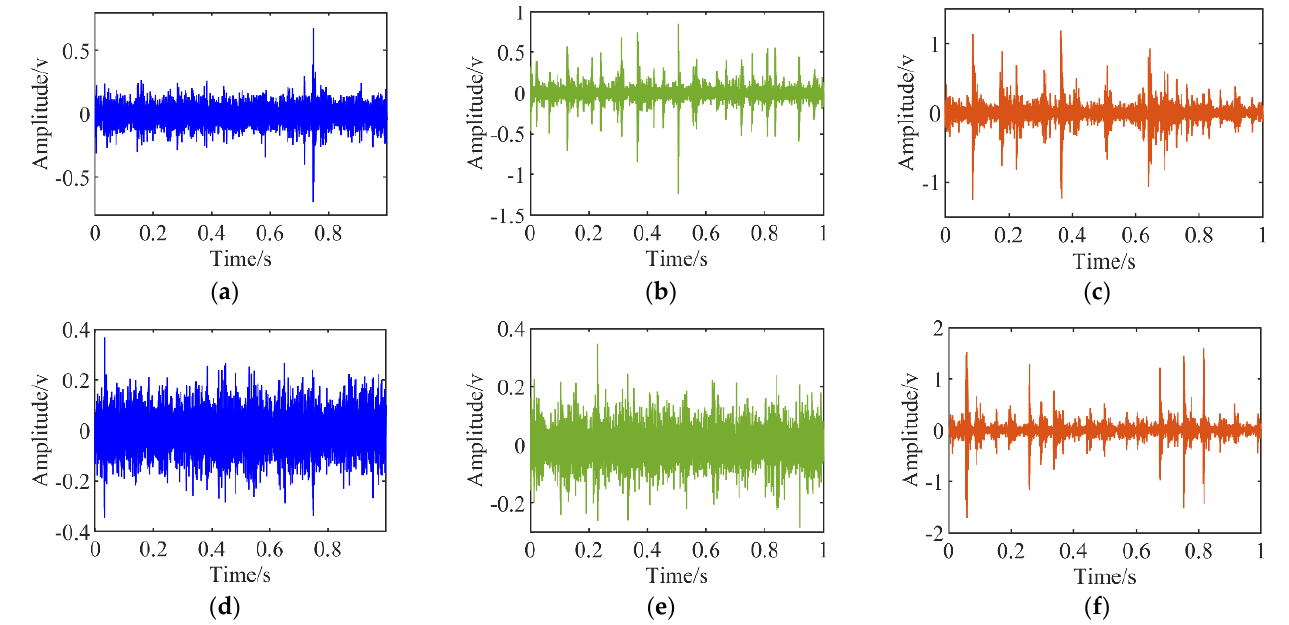
Figure 9. Signal time-domain waveform. ( a ) The normal; ( b ) Local wear; ( c ) Tooth profile; ( d ) Pitting; ( e ) Tooth root fracture; ( f ) Broken gear teeth.